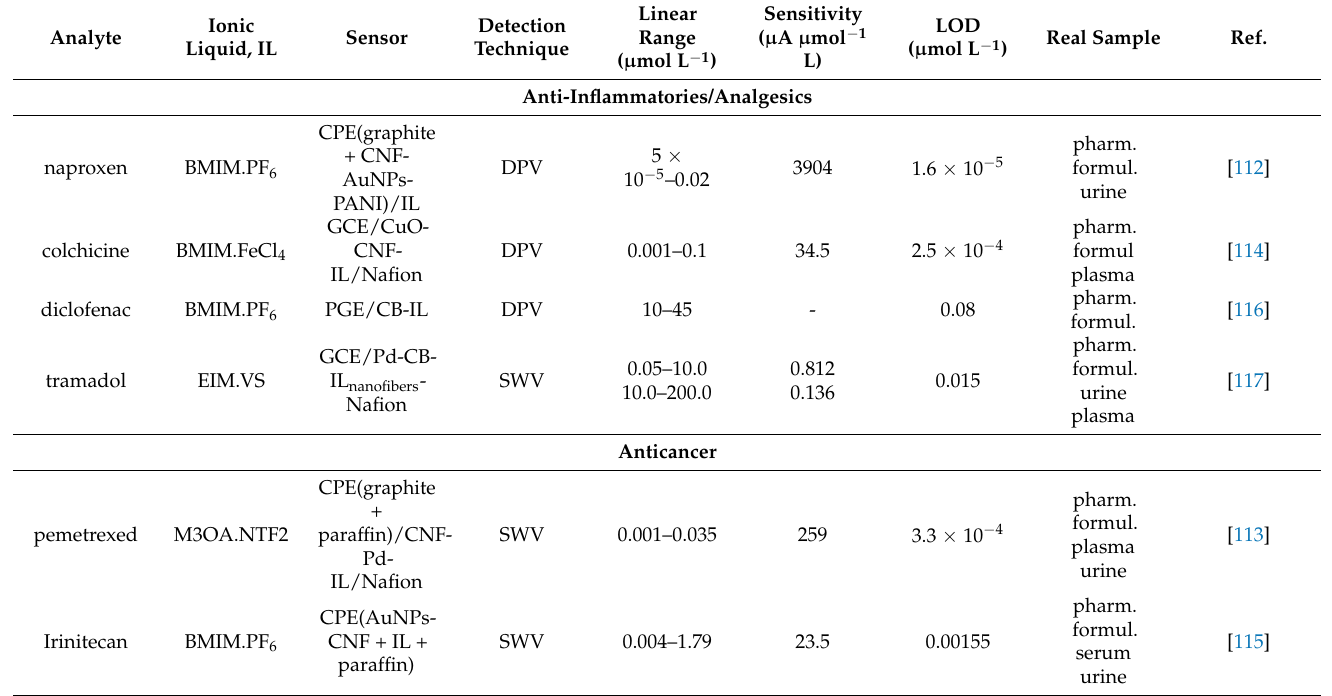
Table 5. Sensors based on other carbon-based IL nanocomposites for pharmaceutical